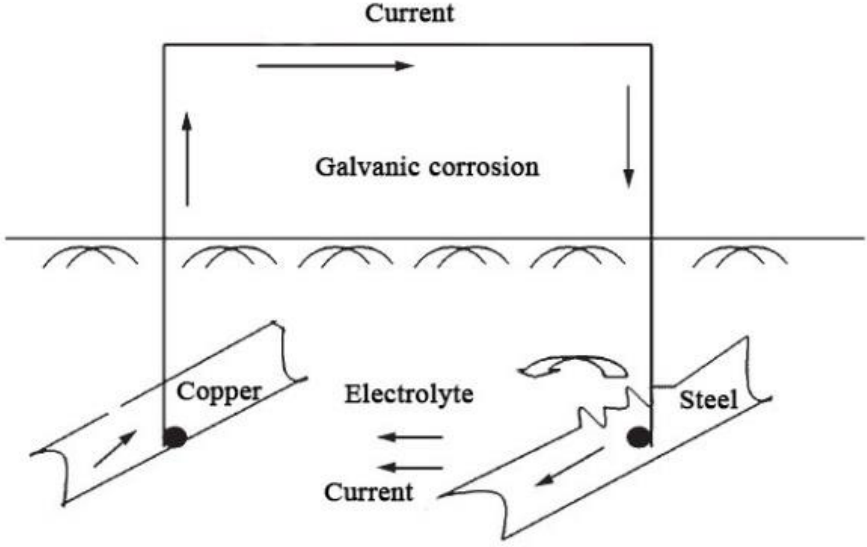
Figure 3. Galvanic corrosion cell formed by the electric contact of two foreign metals.